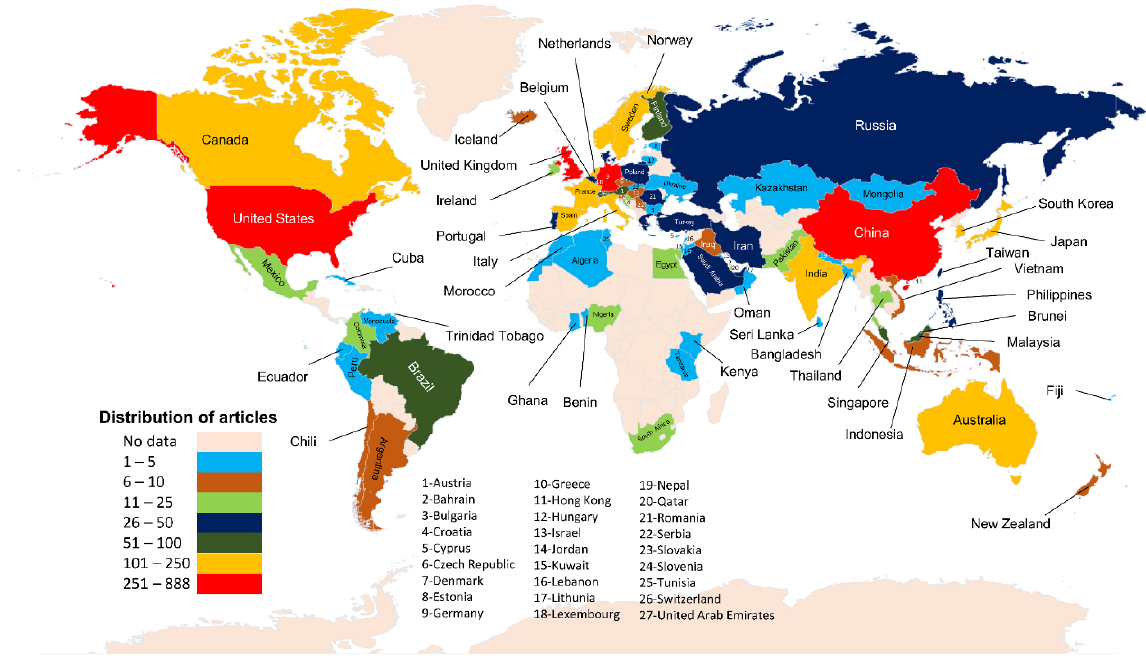
Figure 4. Geographical distribution of published articles on carbon capture and utilization (2007 – 2021).